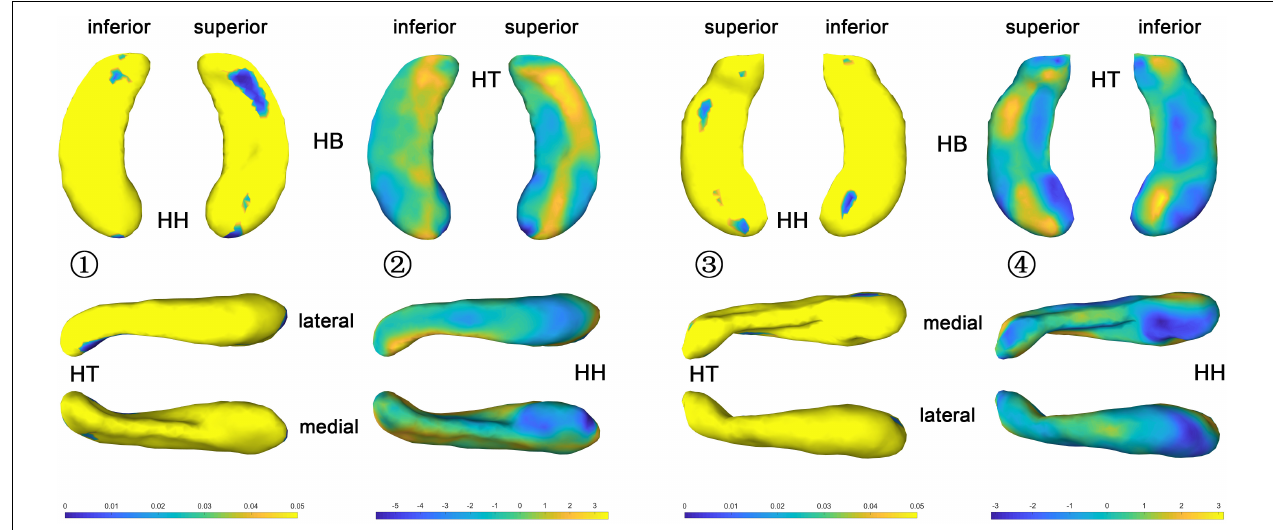
FIGURE 5 | P value and t value maps of late blind subjects compared with control group (uncorrected), from left to right columns are (1) p value map of left HF, (2) t value map of left HF, (3) p value map of right HF, and (4) t value map of right HF, respectively, p < 0.05 was considered as statistically significant. HH, hippocampal head; HB, hippocampal body; HT, hippocampal